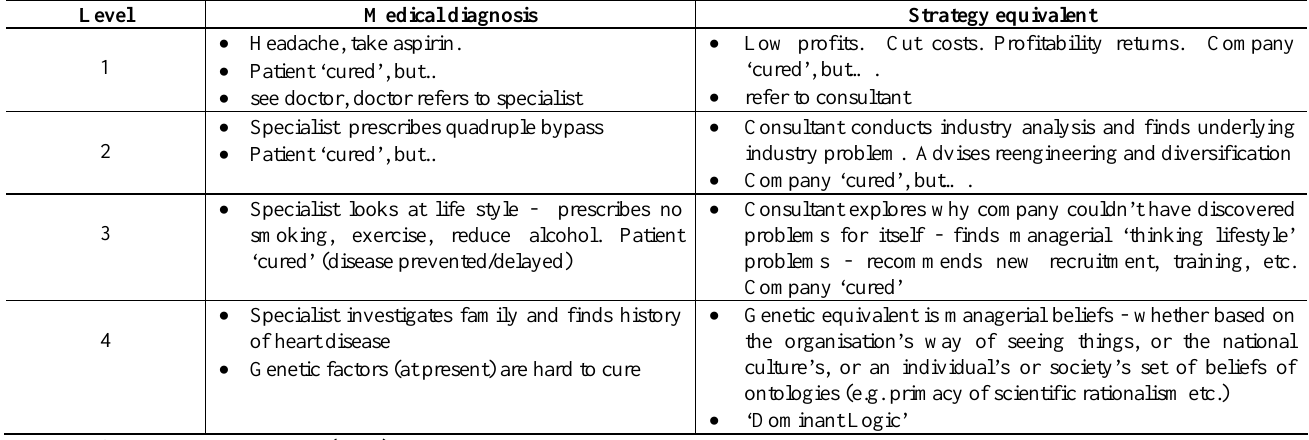
Table 1: Diagnostic depth Level Medical diagnosis Strategy